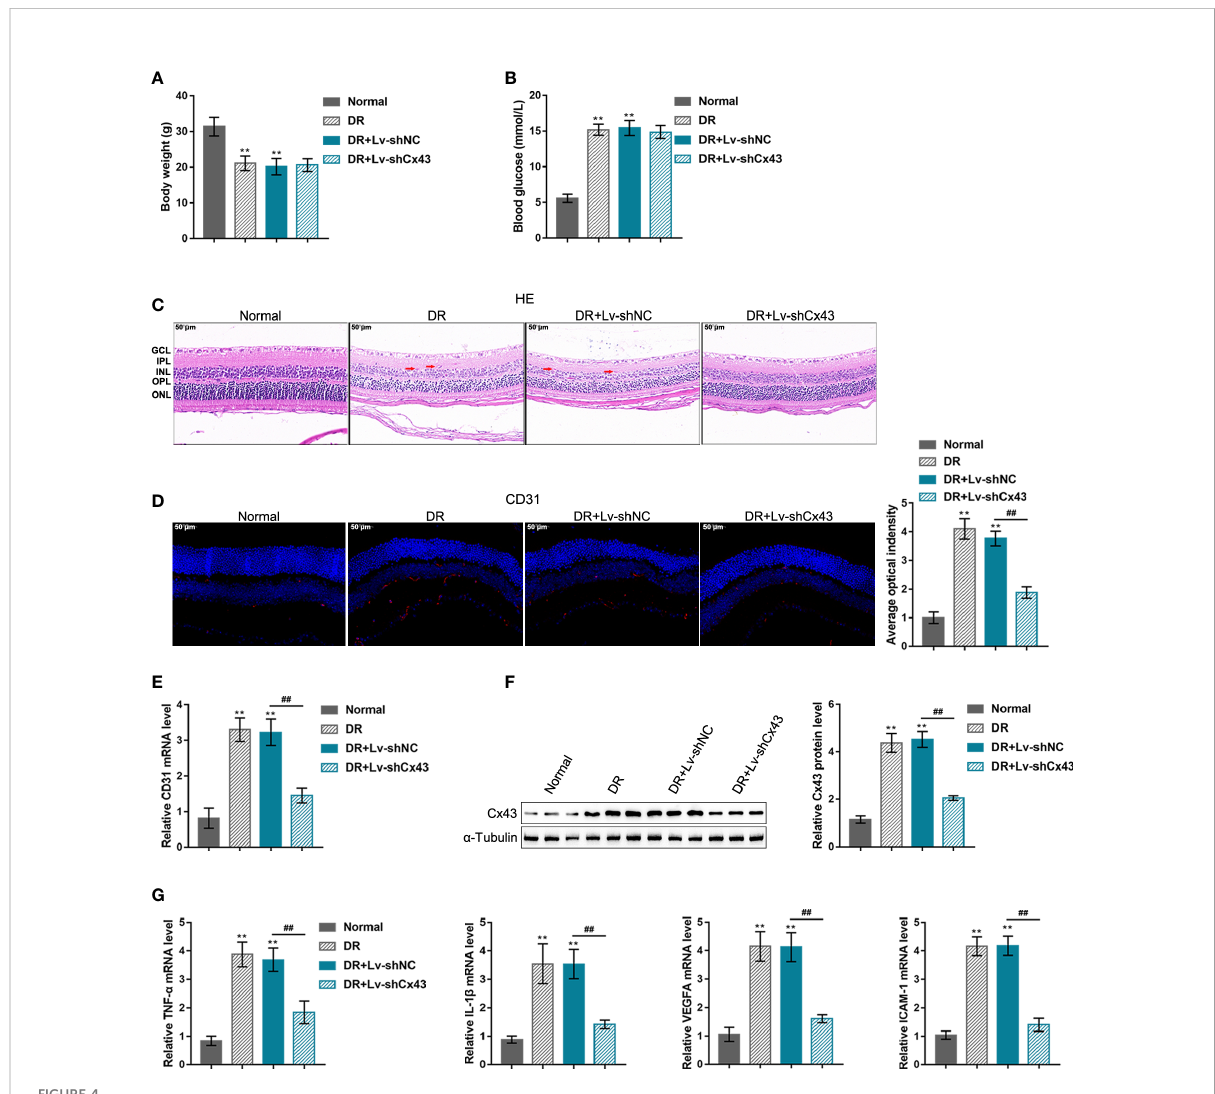
FIGURE 4 in-vivo effects of Cx43 knockdown on the DR mouse model DR model was induced in C57BL/6 J mice and lentivirus infection as previously described. (A, B) Body weight and blood glucose of mice in different groups were determined. (C) The histopathological alterations in the retina were examined using H&E staining. ganglion cell layer (GCL); inner plexiform layer (IPL); inner nuclear layer (INL), outer plexiform layer (OPL); outer nuclear layer (ONL). Red arrows indicated microvessels. (D) CD31 levels in the retina were examined using IF staining. (E) The mRNA expression of CD31 in the retina was determined using qRT-PCR. (F) The protein levels of Cx43 in the retina were determined using Immunoblotting. (G) The mRNA expressions of TNF- a , IL-1 b , VEGFA, and ICAM-1 in tissue samples were examined using qRT-PCR. n = 6, **p < 0.01 compared with normal group; ## p < 0.01 compared with DR+Lv-shNC